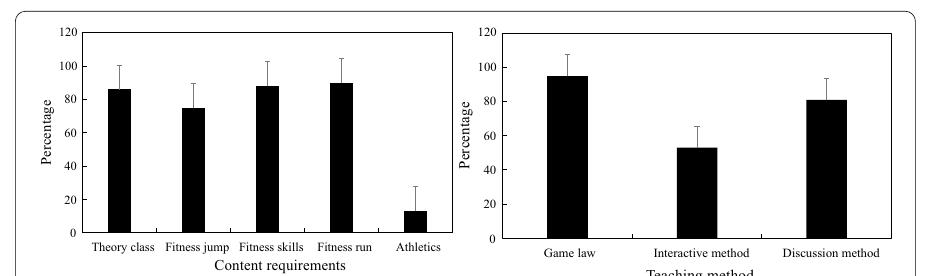
Fig. 9 Students’ specific requirements for track and field teaching content and teaching